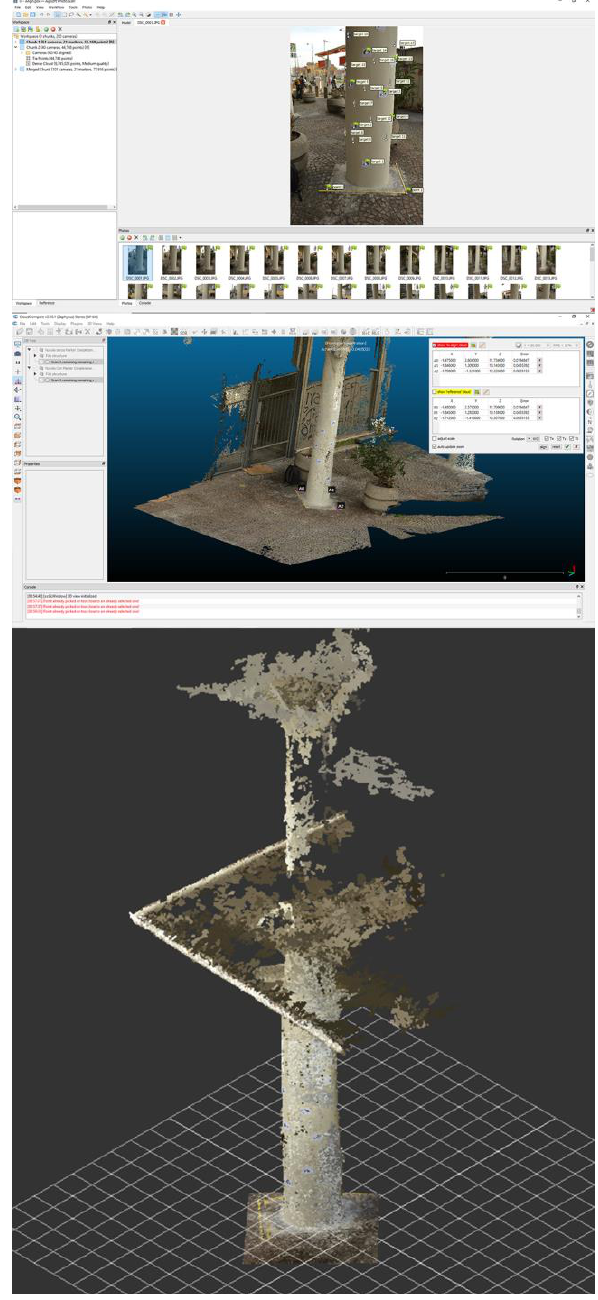
Figure 4. Creating the column point cloud. On the top, reconstruction of the point cloud through digital photogrammetry. On the centre, cleaning phase. On the bottom, final phase and